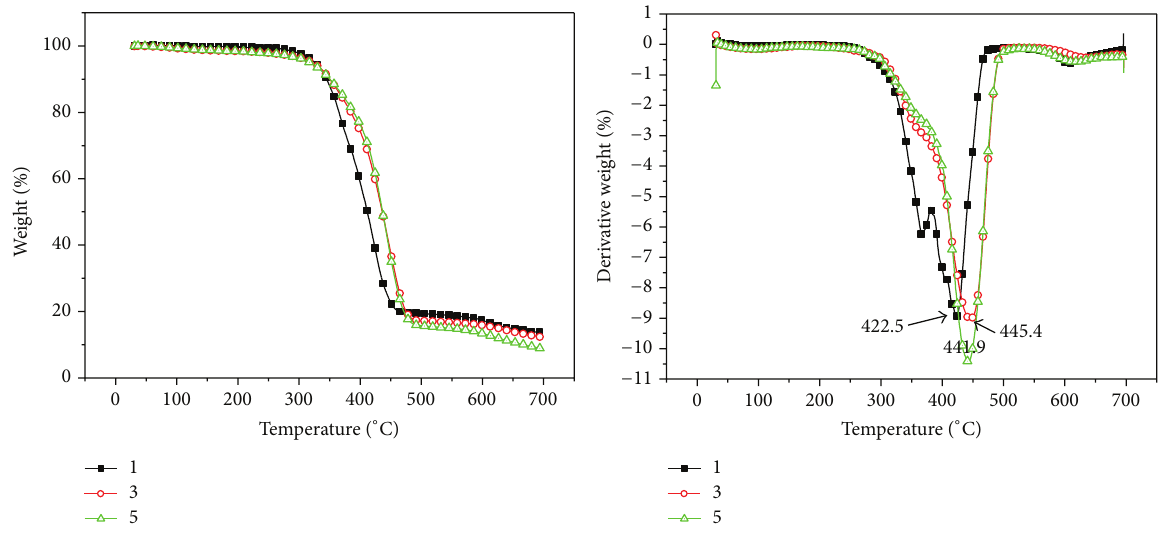
Figure 3: TGA and DTG curves of PP/27%IFR, PP/27%IFR/3%PETA, PP/27%IFR/6%PETA.